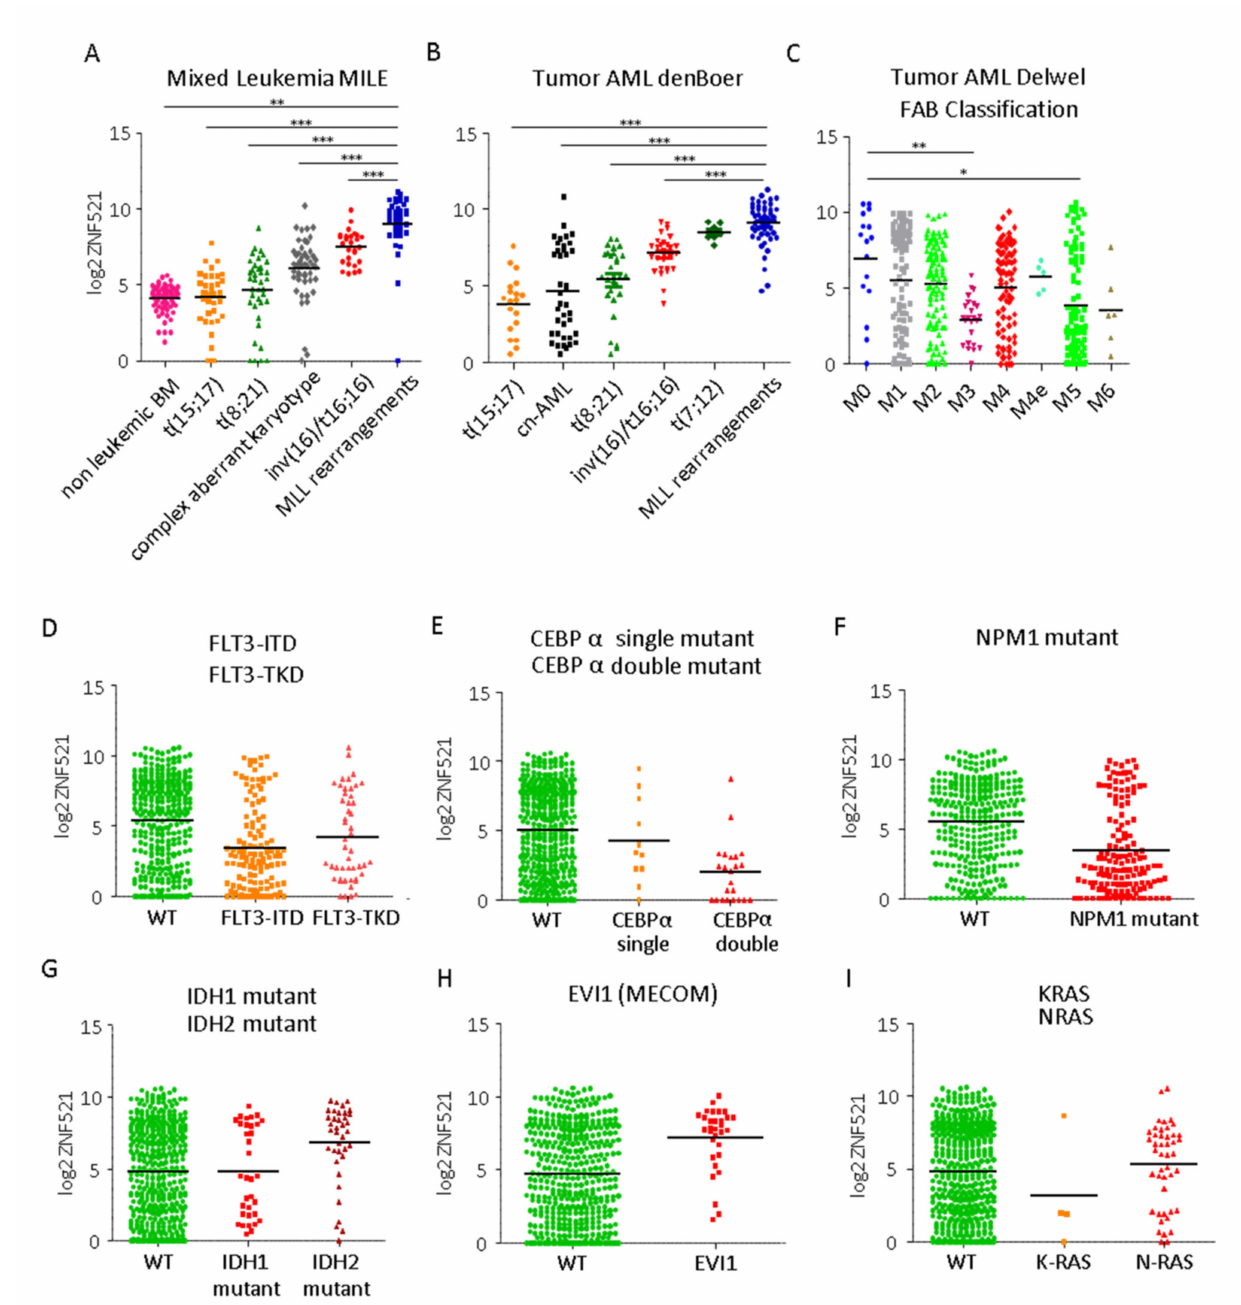
Figure 1. ZNF521 gene expression levels according to cytogenetic groups and FAB classification. ( A ) ZNF521 mRNA expression levels were analyzed in different cytogenetic groups compared to normal karyotype AMLs from the MILE data set (GSE13204). Significant p values: MLL rearrangement vs. non leukemic bone marrow, p = 8.85 × 10 –3 ; MLL vs. t(15;17), p = 3.97 × 10 –4 ; MLL vs. t(8;21), p = 7.01 × 10 –4 ; MLL vs. complex aberrant karyotype, p = 2.381 × 10 –9 ; and MLL vs. inv(16)/t(16;16), p = 2.611 × 10 –3 . ( B ) den Boer data set (GSE17855): Significant p values: MLL vs. t(15;17), p = 1.15 × 10 –18 ; MLL vs. cn–AML, p = 1.31 × 10 –14 ; MLL vs. t(8;21), p = 3.73 × 10 –13 ; 16)/t(16;16), p = 5.03 × 10 –8 . ( C ) ZNF521 mRNA expression analyzed with respect to FAB subgroup classification of AMLs (GSE6891). Significant p values: MO vs. M3, p = 6.02 × 10 –3 and MO vs. M5 p = 4.47 × 10 –2 . ZNF521 mRNA expression level in 460 pediatric and adult AML